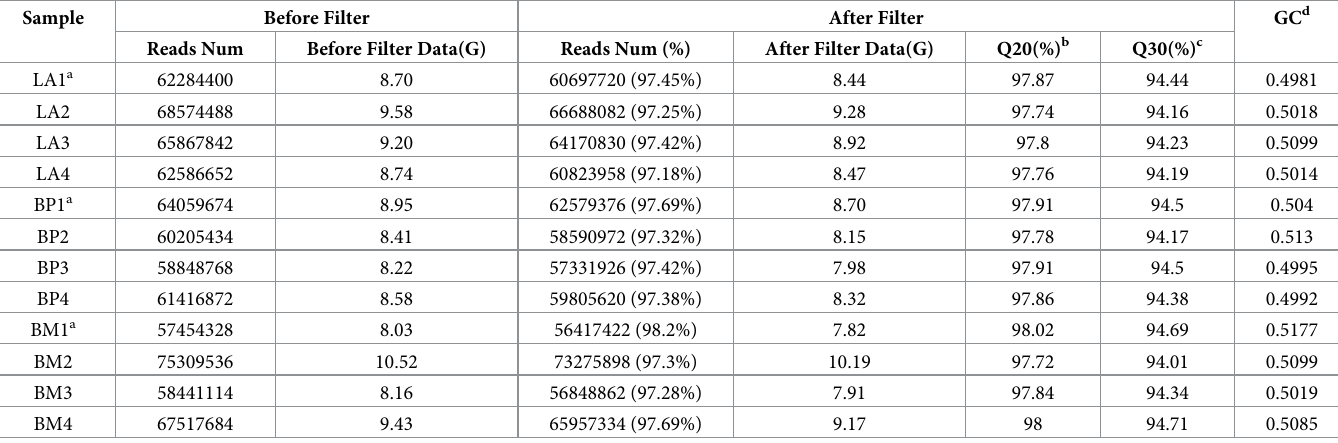
Table 1. Characteristics of the sequence reads from 12 hypothalamic libraries in Muscovy duck.